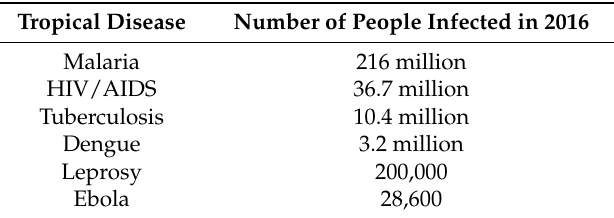
Table 1. Infectious disease cases [1–6].